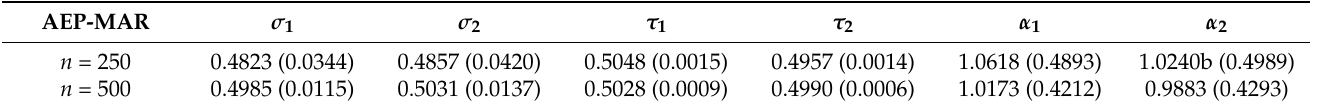
Table 4. Simulation results of AEP-MAR for Scenario 2